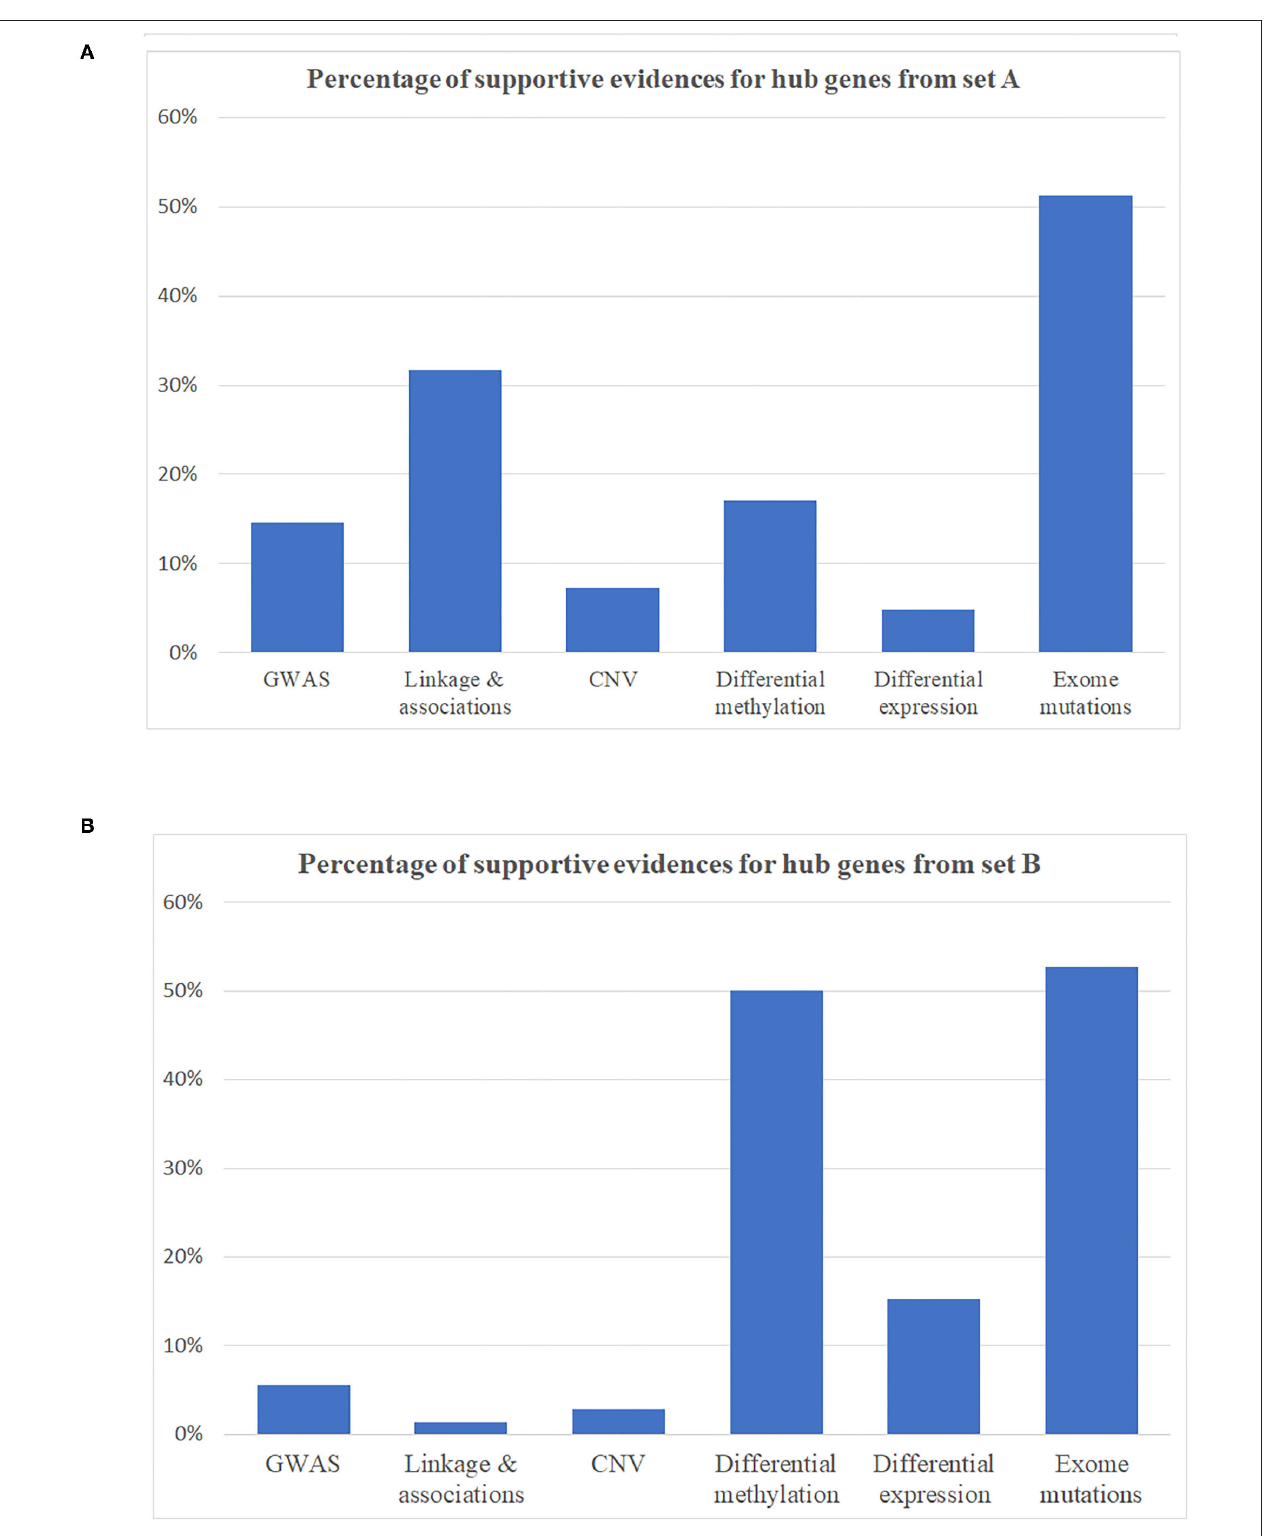
FIGURE 3 | Percentage of supportive evidence for hub genes in expanding networks. (A) Hub genes from disease identified as schizophrenia-associated genes (gene set A). (B) Hub genes from gene set B.